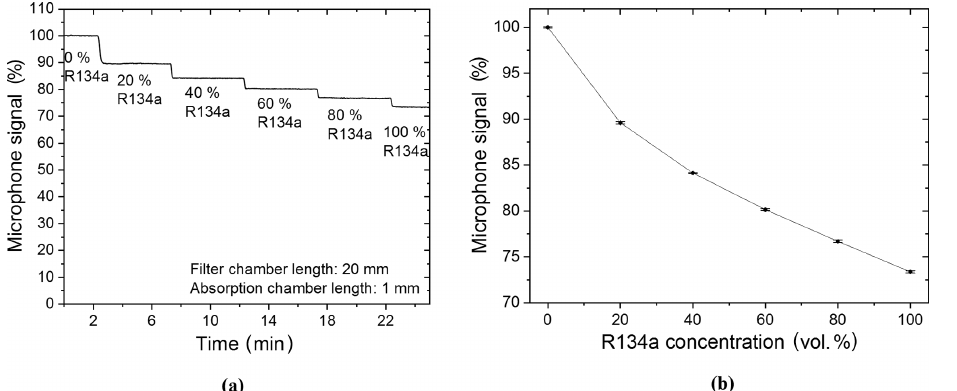
Figure 8. (a) Two-chamber-based R134a detector measurements of different concentrations of R134a (mixed with N 2 ). (b) The resulting exponentially decaying relation between the microphone signal and the R134a volume concentration when the R134a concentration is varied in the absorption chamber. A simplified expression of the resulting exponential decay is f ( x ) = b x , while 0 < b < 1.